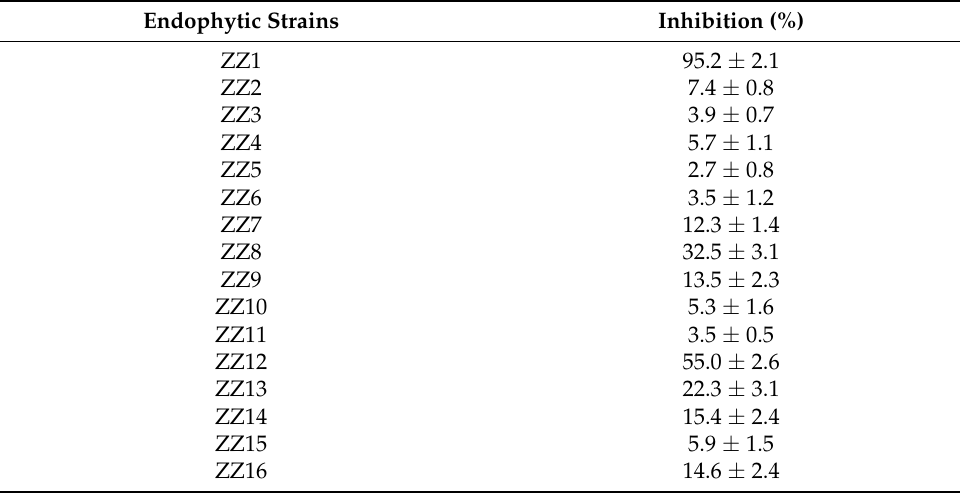
Table 1. The inhibition of endophytic fungal strains against V. pyri